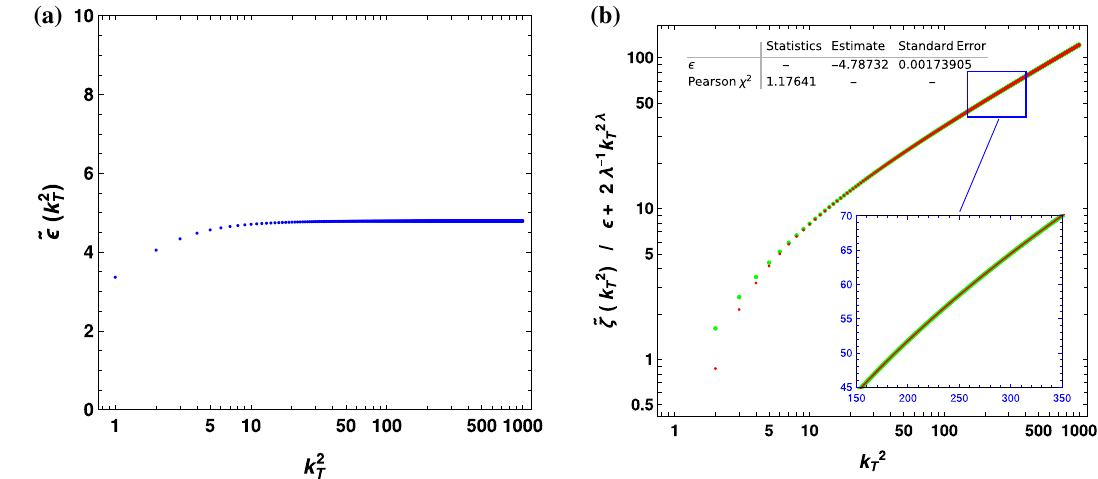
Fig. 3 a k 2 dependence of the small perturbation ˜ (cid:13) = | (cid:13) | corresponding to the term with the hypergeometric function in (17) (left). b A T phenomenologicalcalculationof (cid:13) usingstandardnon-linearregression(right).Comparisonbetween ˜ ζ = π α (red dotted line) is